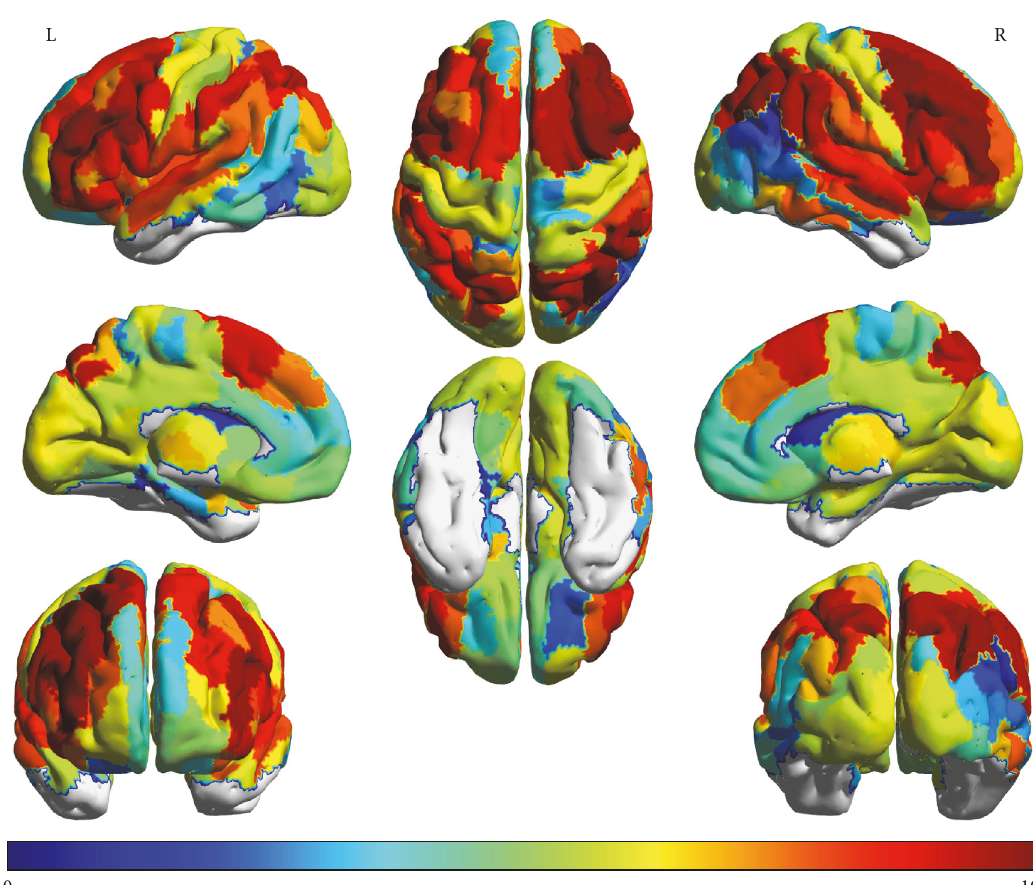
Figure 5: Consistency of the assignment of brain regions to modules measured as the frequency of occurrence of the node with a specific label (in percent) for SYNC